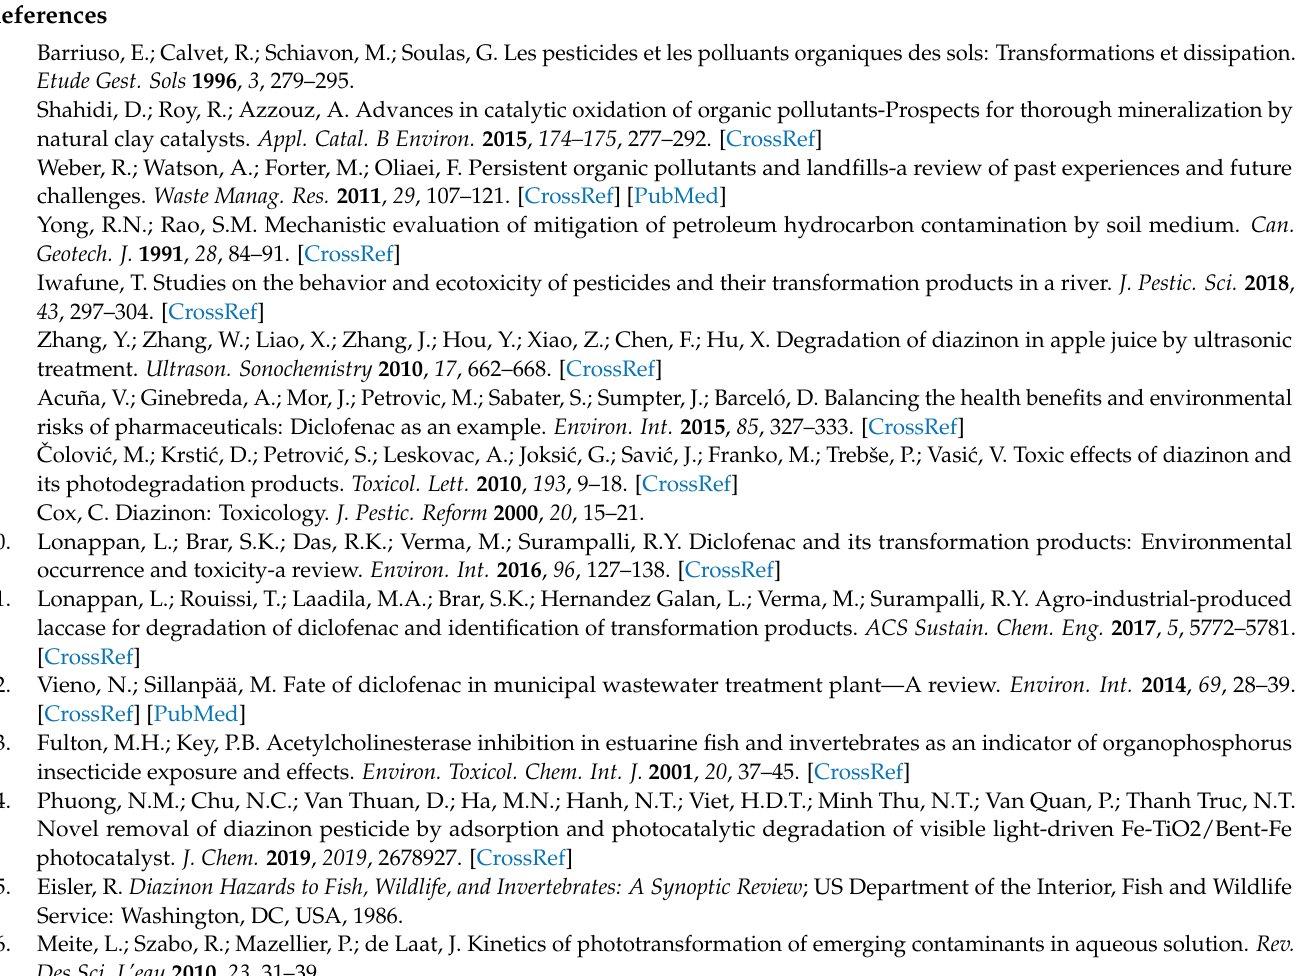
rate on different clay catalysts. Figure S2: Pseudo-first order plot for organic substrate adsorption on different clay minerals. Figure S3: Pseudo-first order plot for organic substrate adsorption on different clay minerals. Figure S4: Langmuir’s model plot for organic substrate adsorption on different clay minerals. Figure S5: Freundlich’s model plot for organic substrate adsorption on different clay minerals. Figure S6: Effect of ozonation time on chlorophyll A-to-chlorophyll B ratio. Table S1: HPLC-UV operating conditions of the Agilent-Cary 60 device (Agilent Technologies, USA); Table S2: Some features of organic substrate in aqueous solutions and corresponding clay